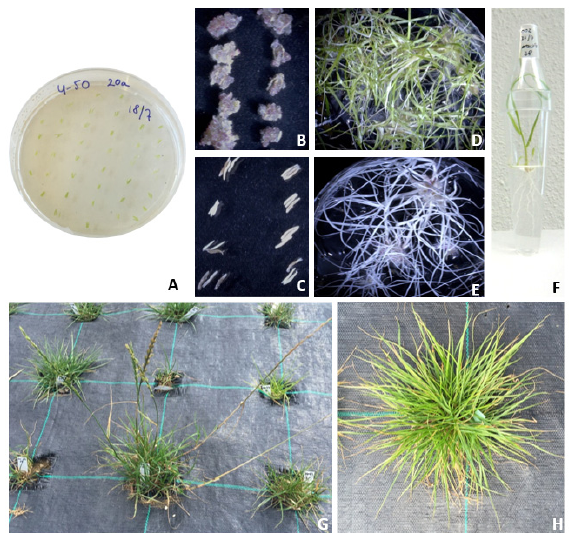
Figure 1. Different stages of perennial ryegrass ( Lolium perenne L.) anther culture (AC) and doubled haploid (DH) production. ( A ) Fresh anthers on DH induction medium; ( B ) anthers of a responsive donor genotype producing many embryo-like structures (ELS) on DH induction medium, six weeks post AC; ( C ) anthers of an unresponsive donor genotype, six weeks post AC; ( D ) green and albino putative DH plantlets growing from ELS cultured on DH regeneration medium, four weeks post subculture; ( E ) albino plantlets growing from ELS, four weeks post subculture; ( F ) putative DH plantlet on regeneration medium; ( G ) flowering DH plant in the field; and ( H ) a vigorous vegetative DH plant in the field (photographs by Begheyn, R.